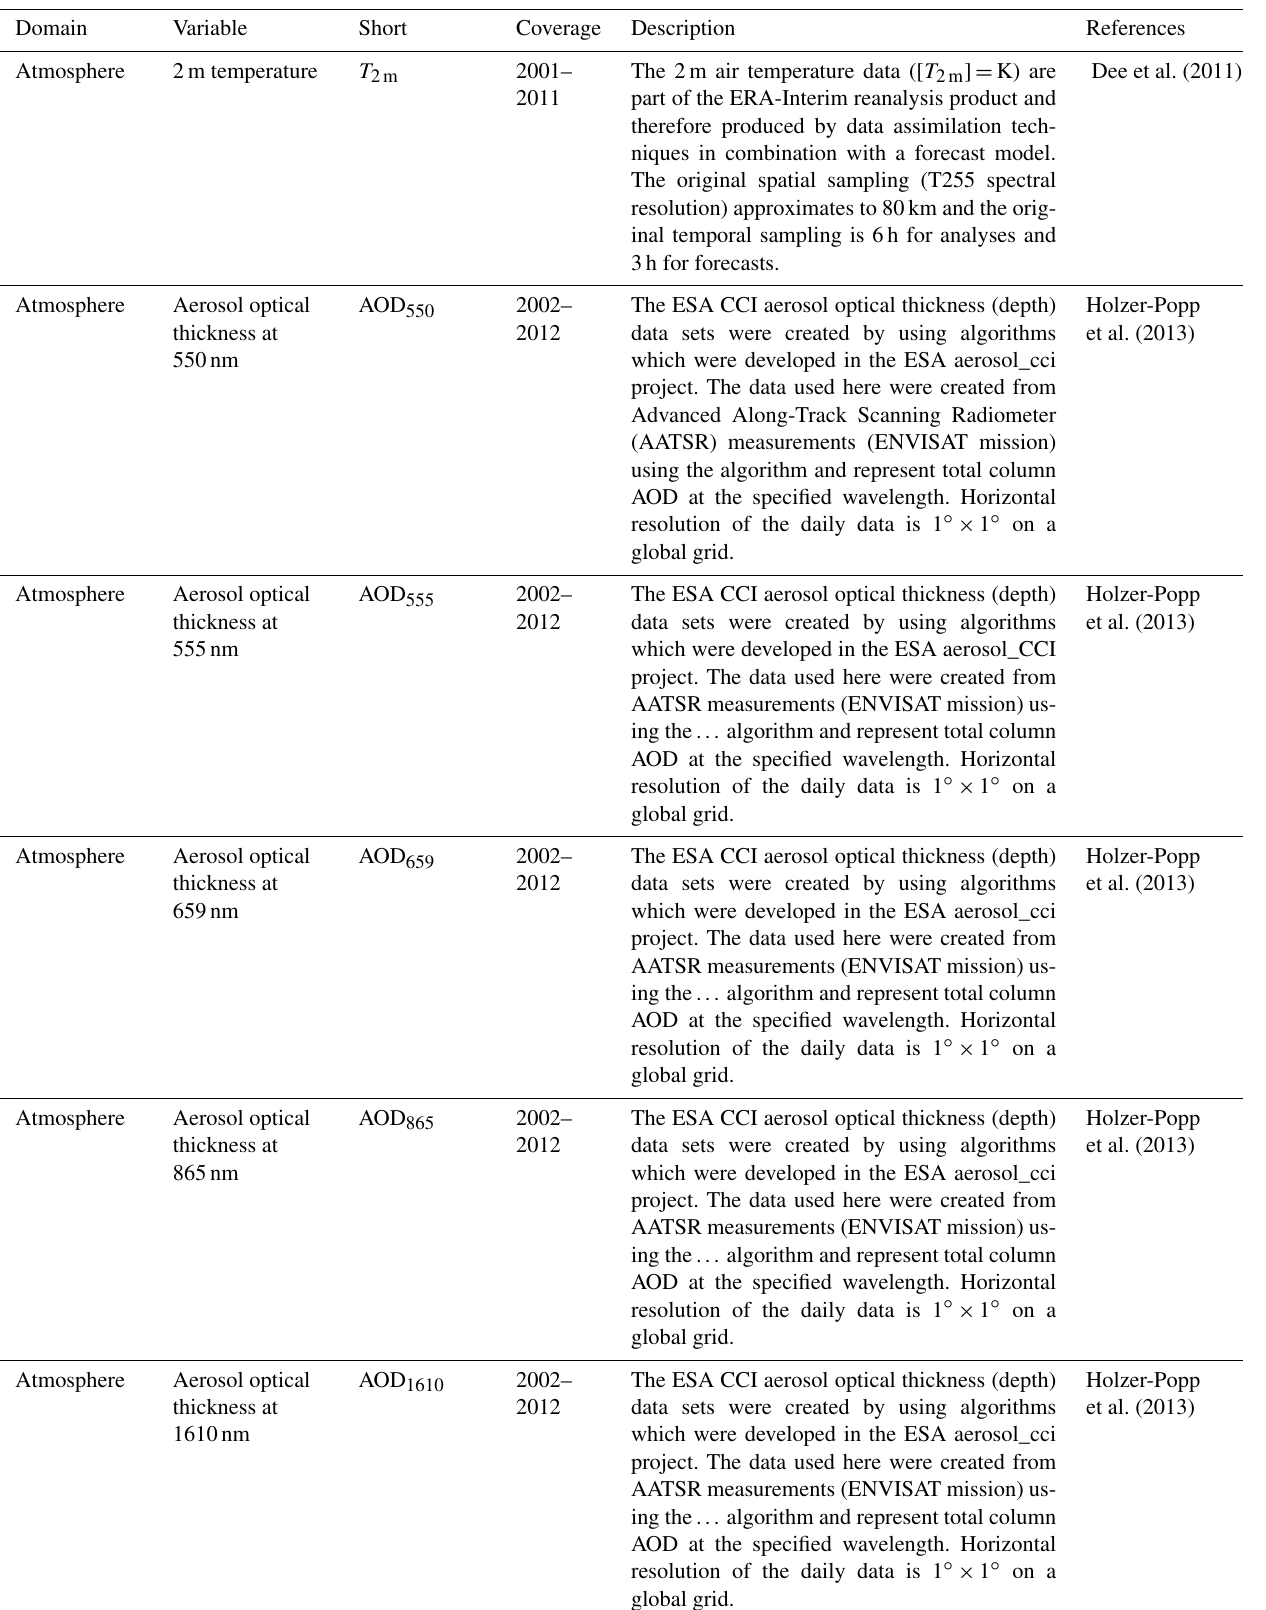
Table A1. Data streams in the current implementation of the ESDL.